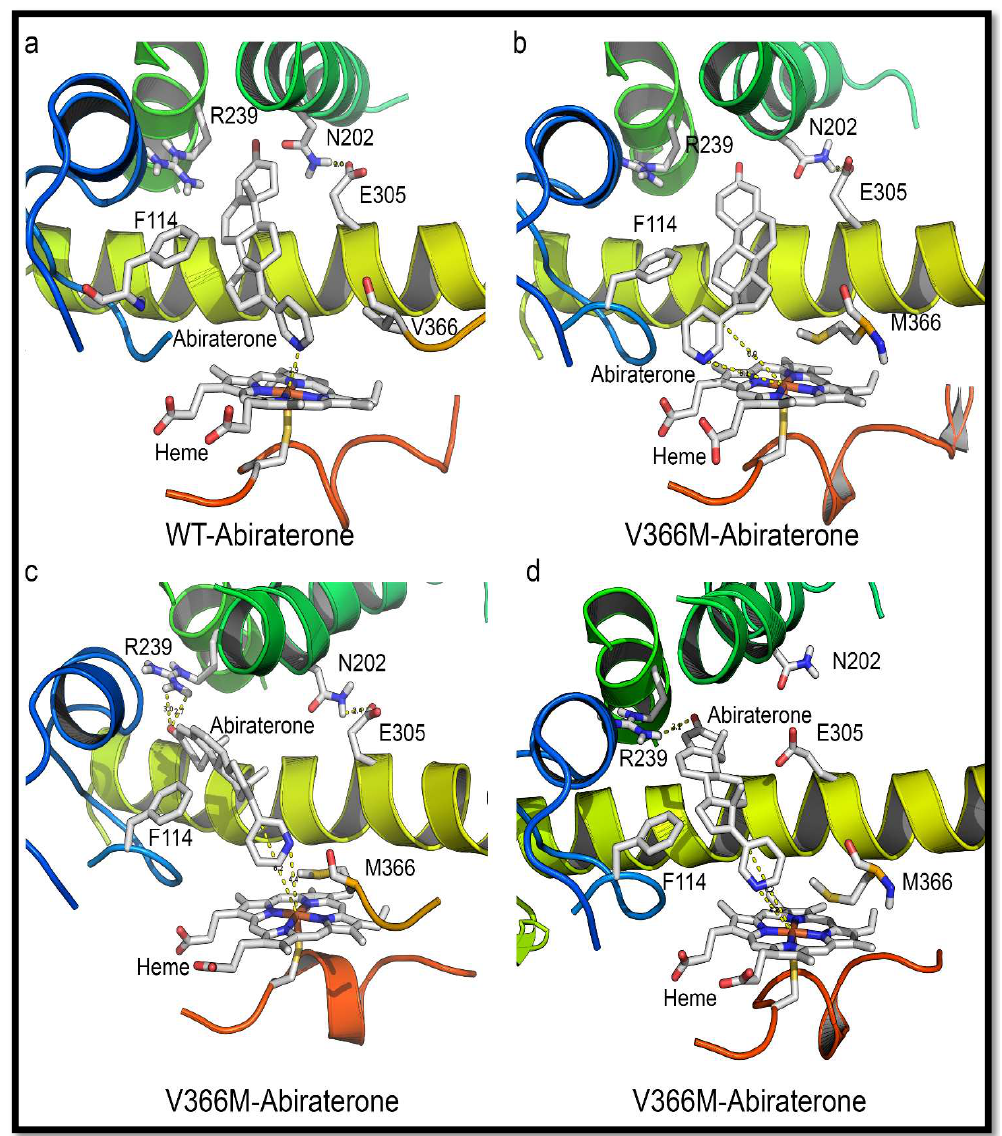
Figure 8. Comparison of abiraterone interaction with the WT and V366M variant of CYP17A1. ( a ) In the WT CYP17A1 abiraterone binds by forming a nitrogen-iron co-ordination (2.9 Å) with the central heme. ( b – d ) Different poses of abiraterone seen during docking into the V366M mutant of CYP17A1. In the V366M mutant, the methionine side chain prevents the binding of abiraterone and increased distances between the C17 atom and heme iron are observed together with binding poses that are different from the